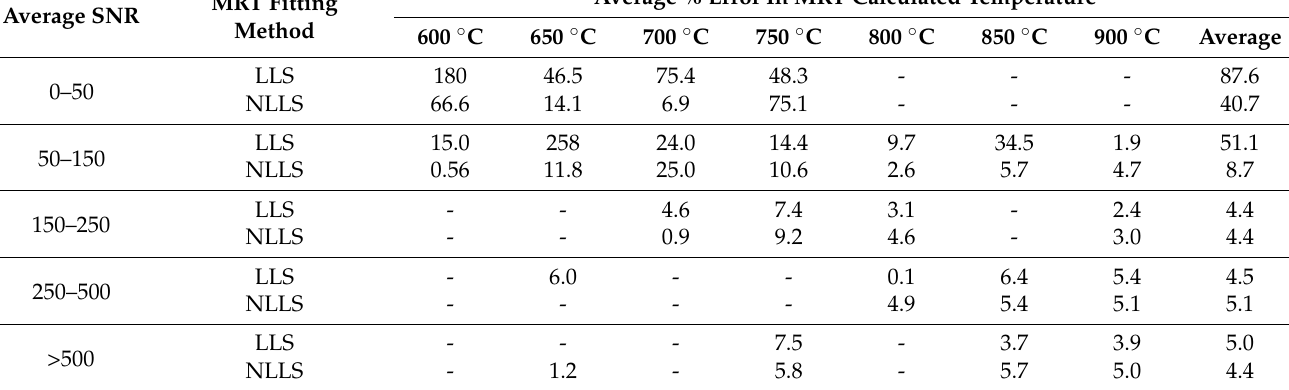
Table 1. Average error in MRT-calculated temperature at different SNR regions (W/m 2 - µ m) using NLLS and LLS methods and the synthetic surface-emission data. The columns break down the results as a function of the seven analysis temperatures and on an average basis across all analysis temperatures. Cells with ‘-’ indicate that the data of Figure S2a,b did not provide points in the corresponding